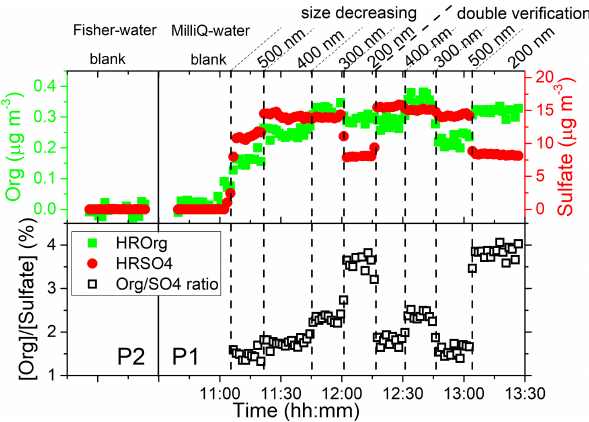
Figure 2. Mass concentrations of total organic matter, sulfate, and [Org] / [Sulfate] ratio as a function of time during one cycle per- formed in EXP P1 at an AS concentration of 0.01M. Background signal obtained with pure water in EXP P1 and P2 is also shown for quality check and for comparison between the two types of water with different